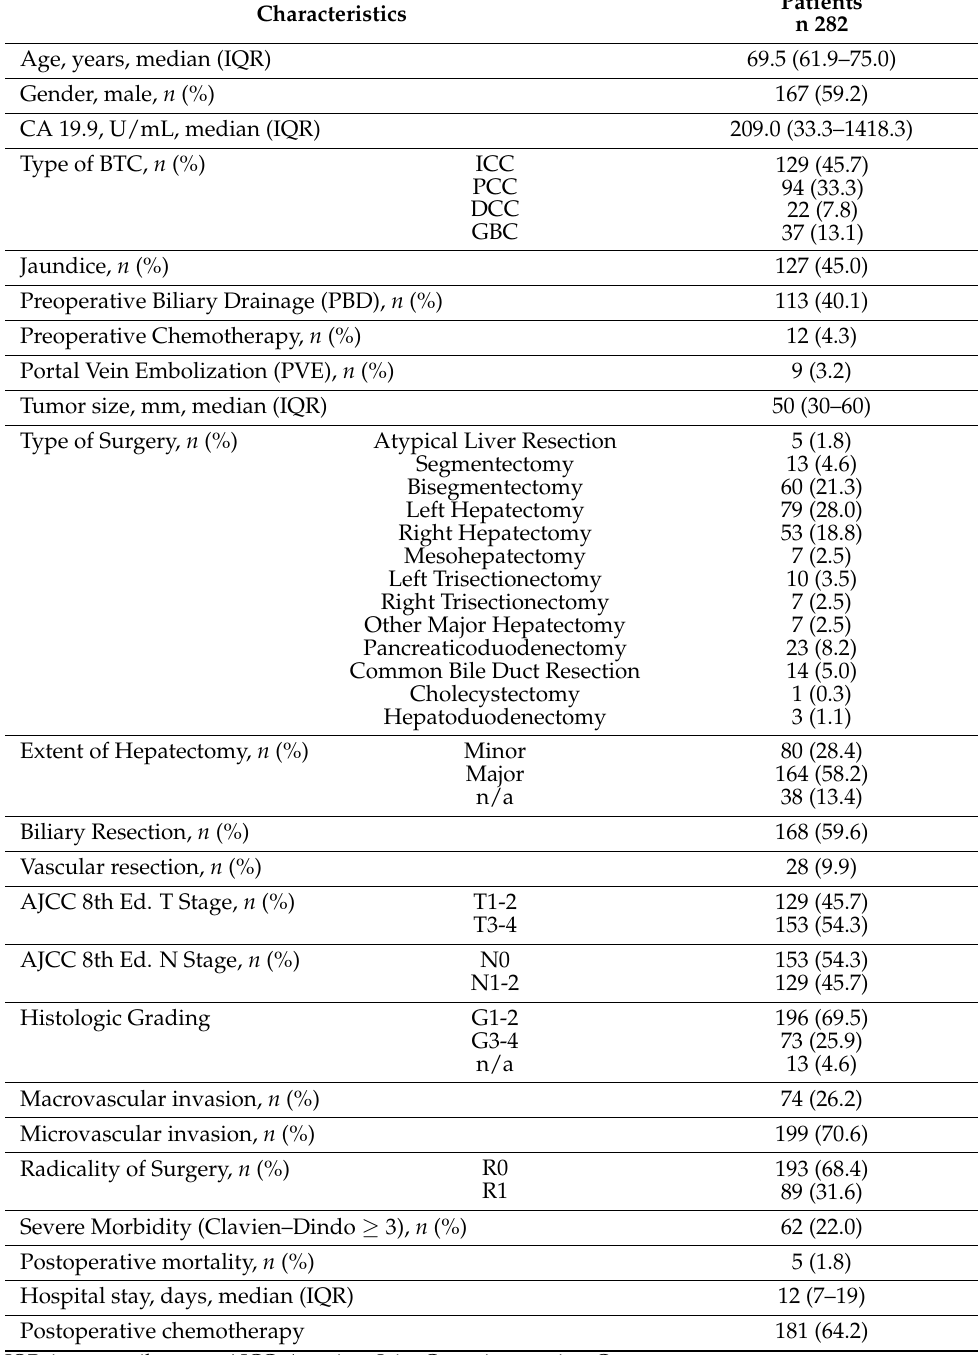
Table 1. Clinical and pathological characteristics of the study